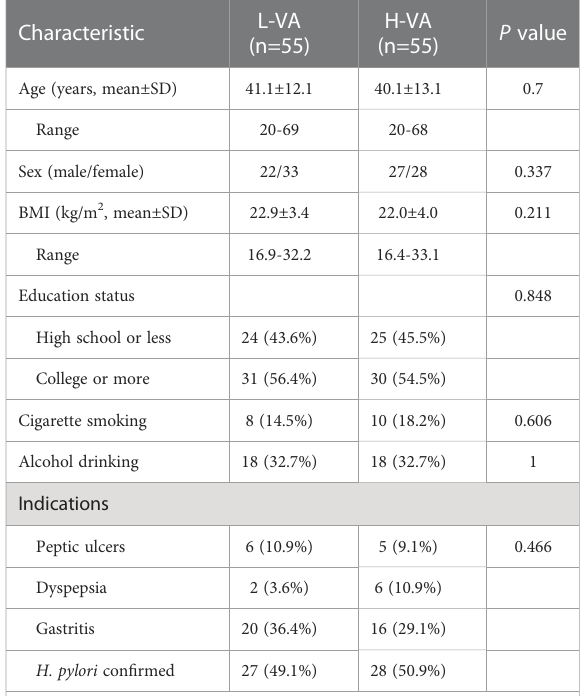
TABLE 1 Baseline characteristics of the participants.